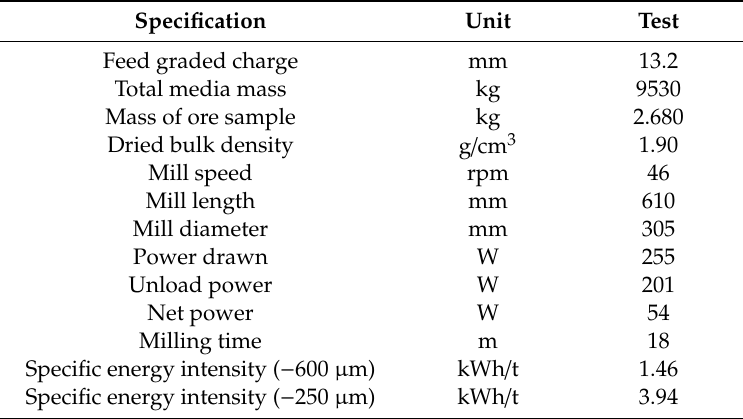
Table 1. Specifications for laboratory rod mill